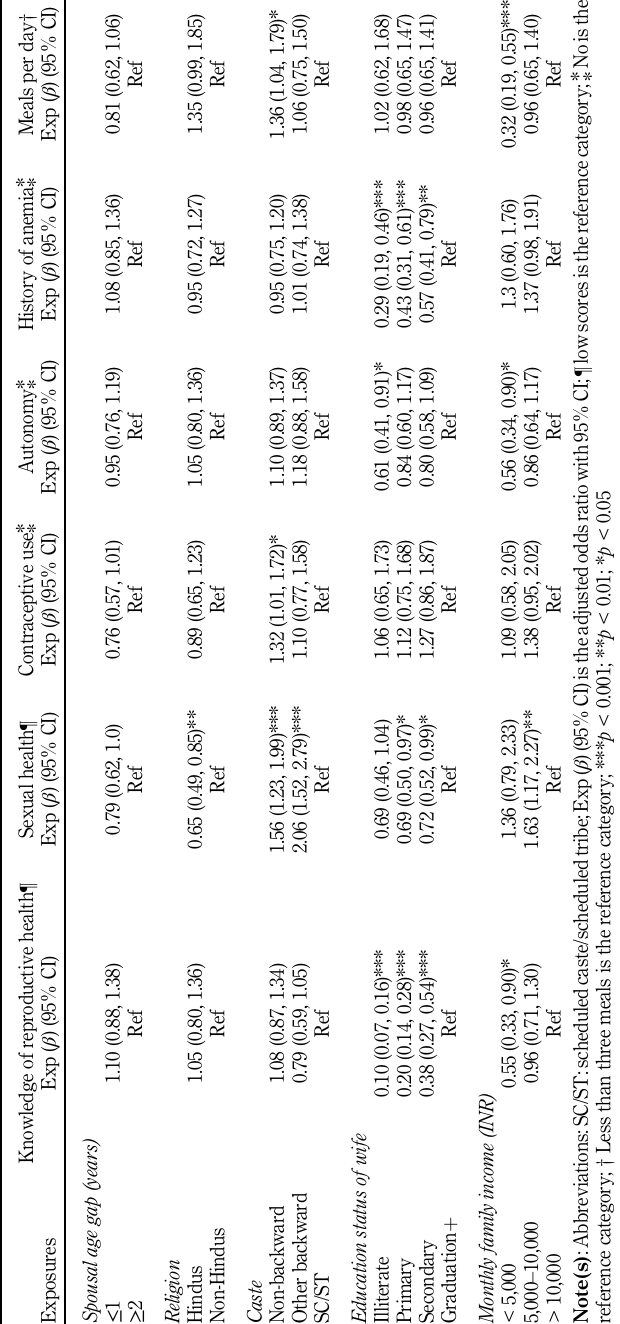
Table 5. Adjusted model of logistic regression to assess the link of spousal age gap and other exposures with preconception health outcomes ( n 5